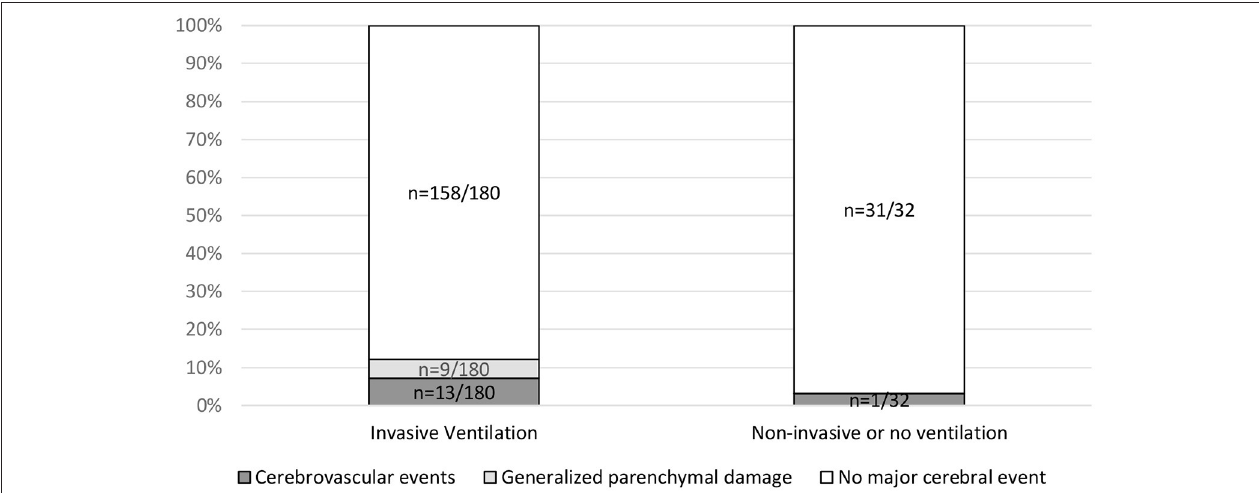
FIGURE 4 | Association of major cerebral events with invasive ventilation. Invasive ventilation includes assisted pressure release ventilation (APRV) and volume controlled continuous mandatory ventilation (VC-CMV). Non-invasive ventilation includes nasal oxygen or continuous positive airway pressure (CPAP) mask. Contingency tables analysis was used to relate ventilation to the parameters cerebrovascular events ( p = 0.39), generalized parenchymal damage ( p = 0.20) and major events ( p = 0.13). Information on the type of ventilation performed was available in 211 of 278 cases.